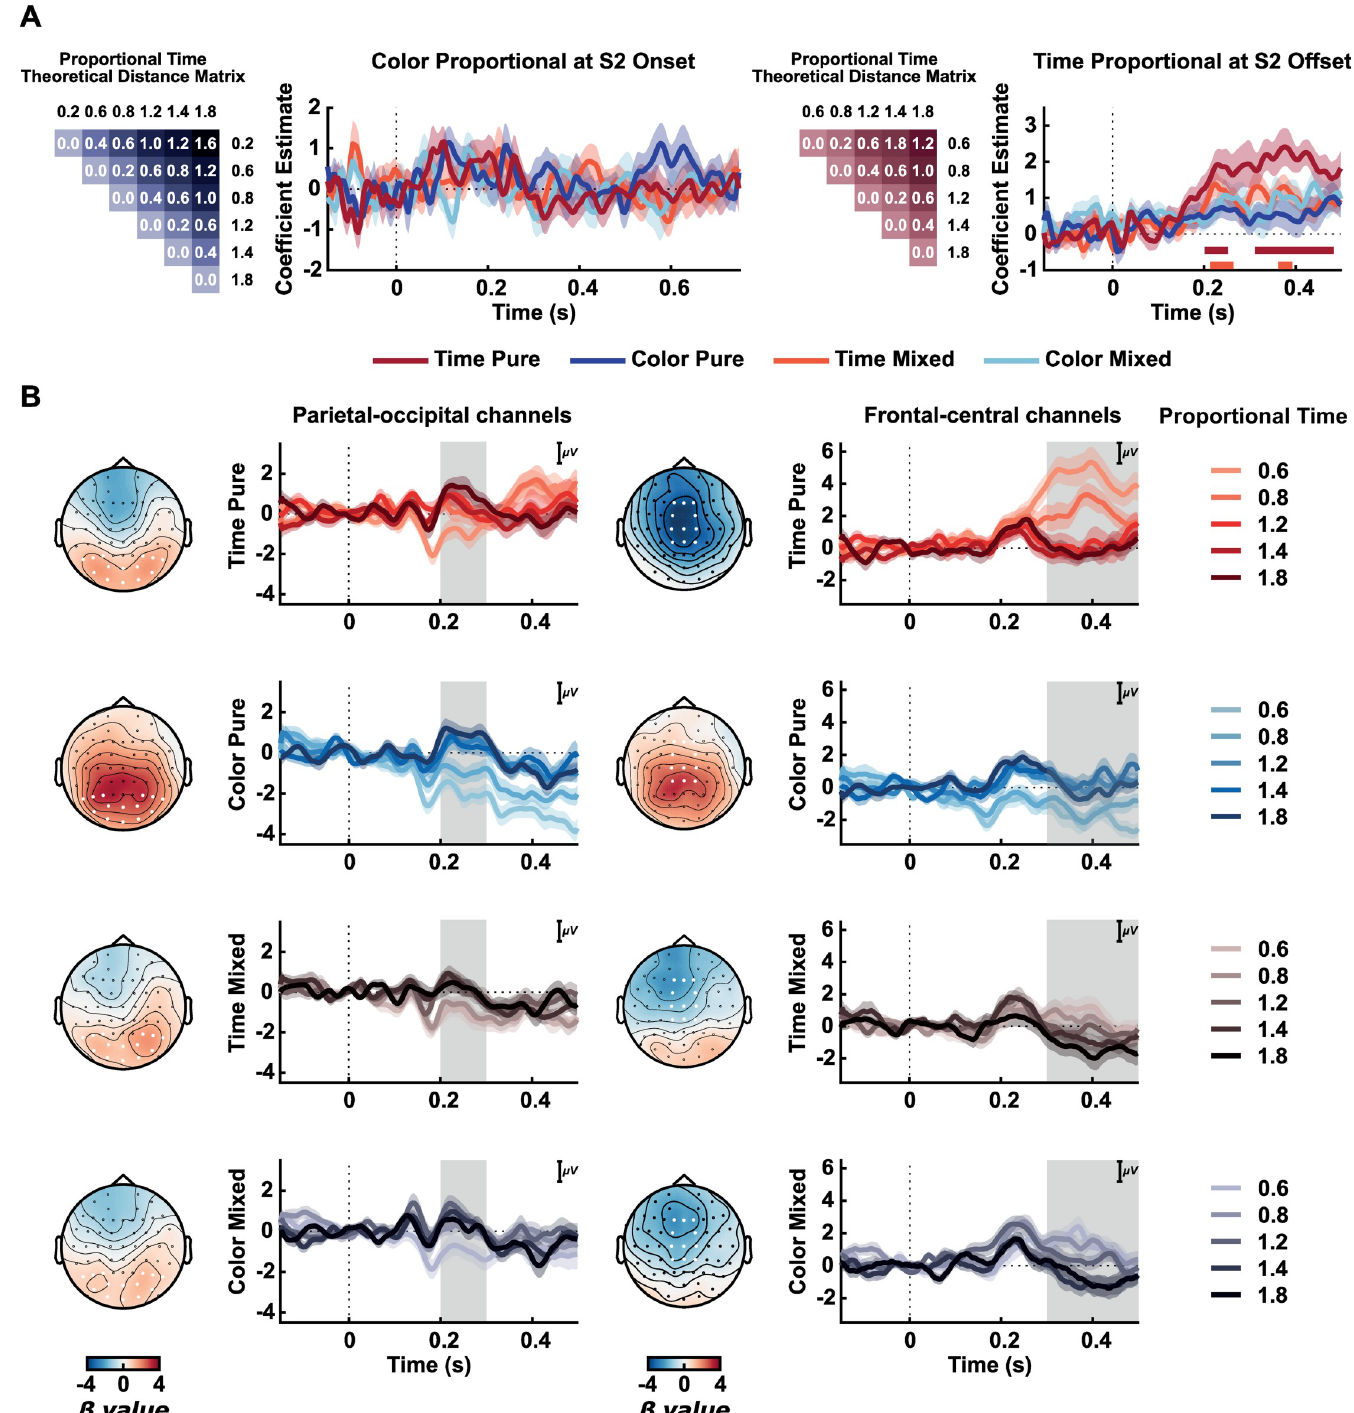
Fig 4. Proportional time and color information at S2 offset. (A) Coefficient estimates from RSA for relative proportional time information at S2 offset (left) and relative proportional color information at S2 onset (right). Matrices depict theoretical models used for RSA for time and color relative from S2 to S1. Curves show mean coefficient values; shaded areas indicate Standard Error of the Mean. Straight Lines below indicate significant windows for RSA’s coefficient estimates for each condition from the permutation test, represented by different colors. (B) Event-Related Potentials for different time proportions and conditions. Topographies of coefficients ( β ) values from the mass univariate regression analysis are shown for different windows. The first column represents ERPs from the selected parietal-occipital electrodes (marked as white, P8, P6, P4, P3, P5, P7, PO8, PO4, POz, PO3, PO7, O1, Oz, O2) in the 200ms to 300ms window (gray area). The second column represents ERPs from the selected fronto-central electrodes (marked as white, F1, Fz, F2, FC1, FC2, C2, Cz, C1, CP1, CPz, CP2) in the 300ms to 500ms window (gray area). https://doi.org/10.1371/journal.pone.0257378.g004 PLOS ONE | https://doi.org/10.1371/journal.pone.0257378 September 27,